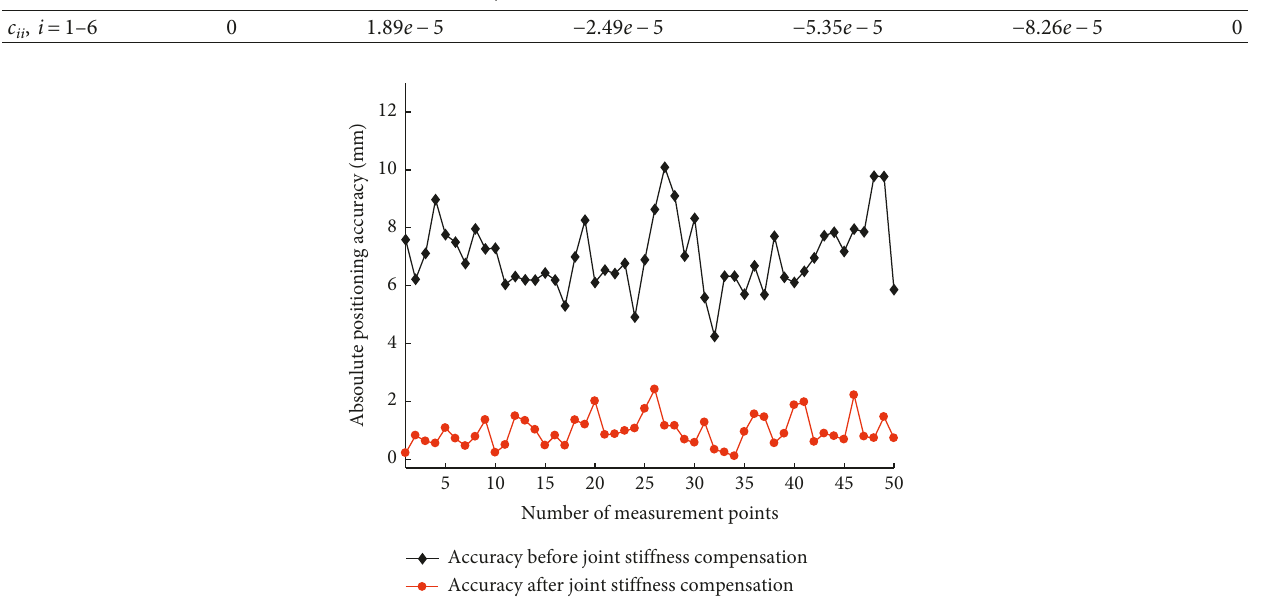
Table 6: Flexibility factors for stiffness calibration identification.